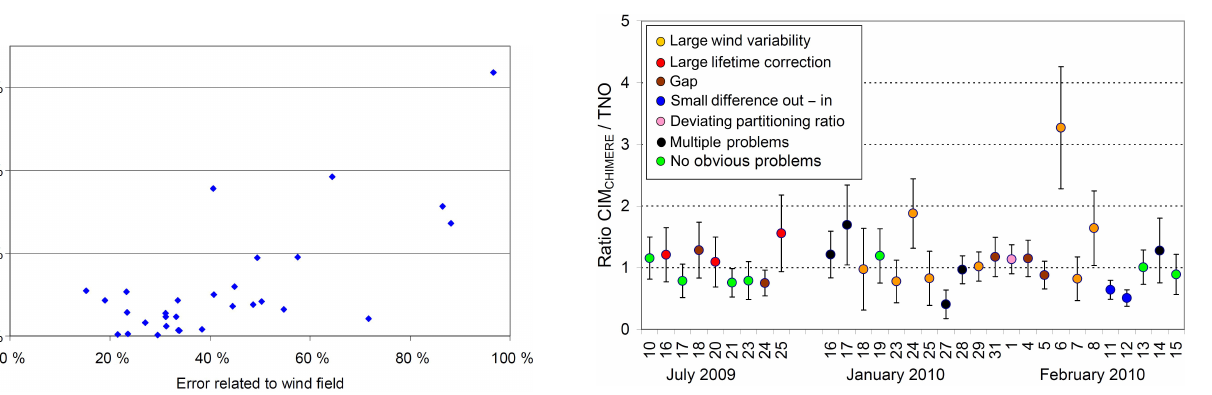
Figure 12. Difference in the NO x emissions derived from either averaged or variable wind data plotted versus the wind-related error calculated as described in Sect. 4.6.3.